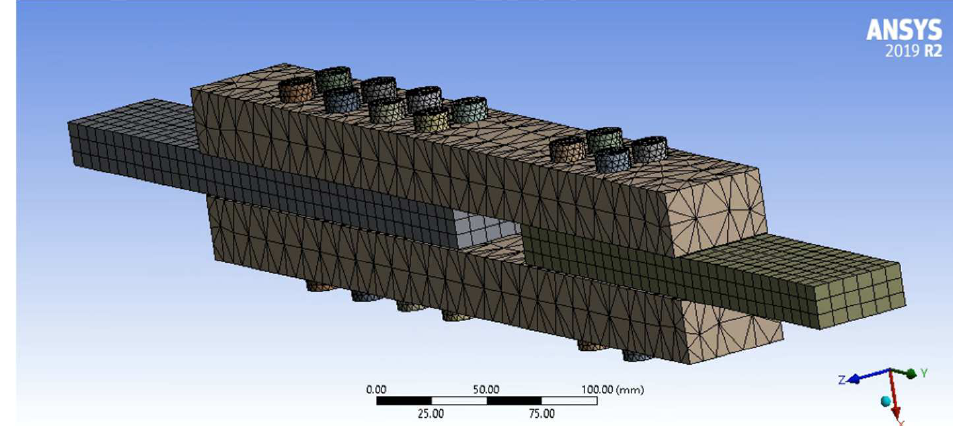
Figure 14. Simulation Mesh. Figure 15. Simulation